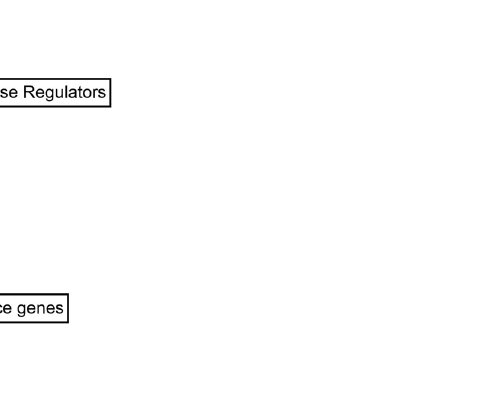
Figure 11. Adhesion of V. cholerae cells to Int 407 cell lines. ( a ) Light microscopy image showed the adhesion of V. cholerae MTCC 3905 to untreated Int 407 cell lines. ( b ) Light microscopy image of the adhesion of V. cholerae MTCC 3905 to Int 407 cell lines treated with CAP-2M4VP nano-formulation. ( c ) Percentage of adherent V. cholerae MTCC 3905 cells to Int 407 cell lines. ( d ) Light microscopy image of the adhesion of V. cholerae HYR14 to untreated Int 407 cell lines. ( e ) Light microscopy image of the adhesion of V. cholerae HYR14 to Int 407 cell lines treated with CAP-2M4VP nano-formulation. ( f ) Percentage of adherent V. cholerae HYR14 to Int 407 cells. Student t -test was used for statistical significance analysis. **Indicates significant difference (** p < 0.01) compared to the untreated.